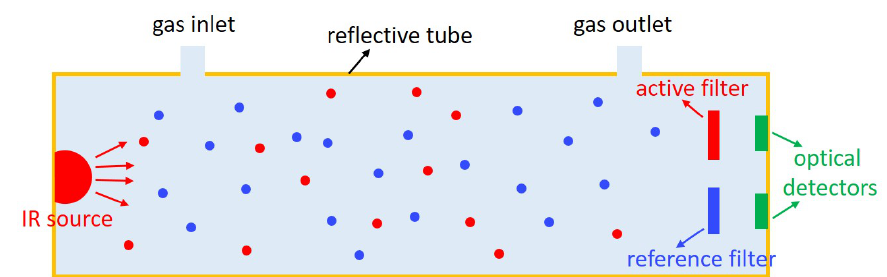
Figure 1. Schematic of a typical NDIR sensor. The sensor consists of an infrared broadband source, a reflecting gas tube with gas inlet and outlet, a pair of optical filters(active and reference), and two optical detectors. The two filters and two detectors form the active channel and reference channel,